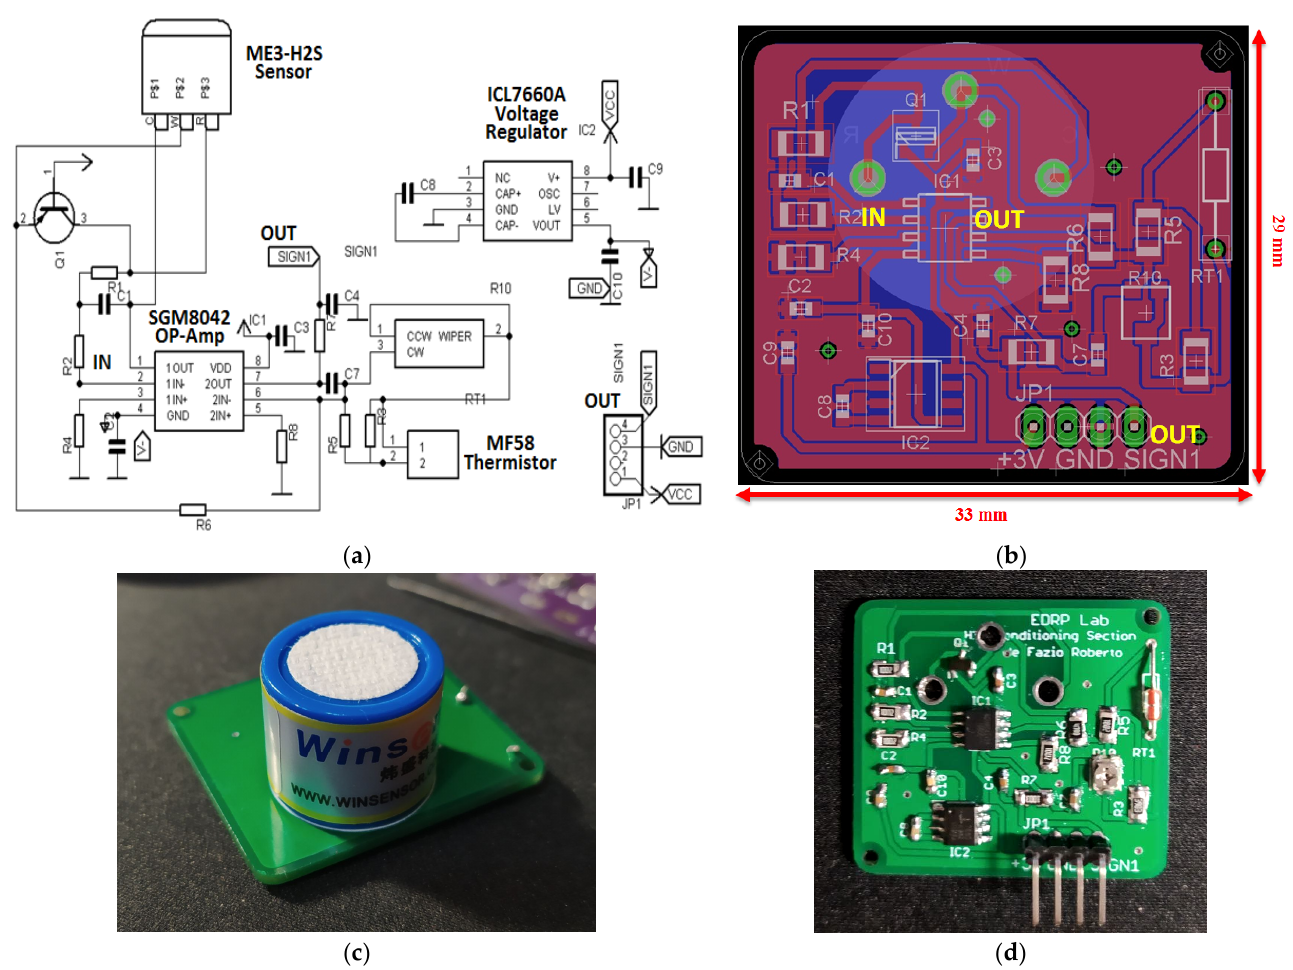
Figure 13. Schematic ( a ), layout ( b ), and PCB top ( c ) and bottom ( d ) views of the ME3-H2S sensor’s conditioning section. Diagrams were realized with the Eagle CAD software.